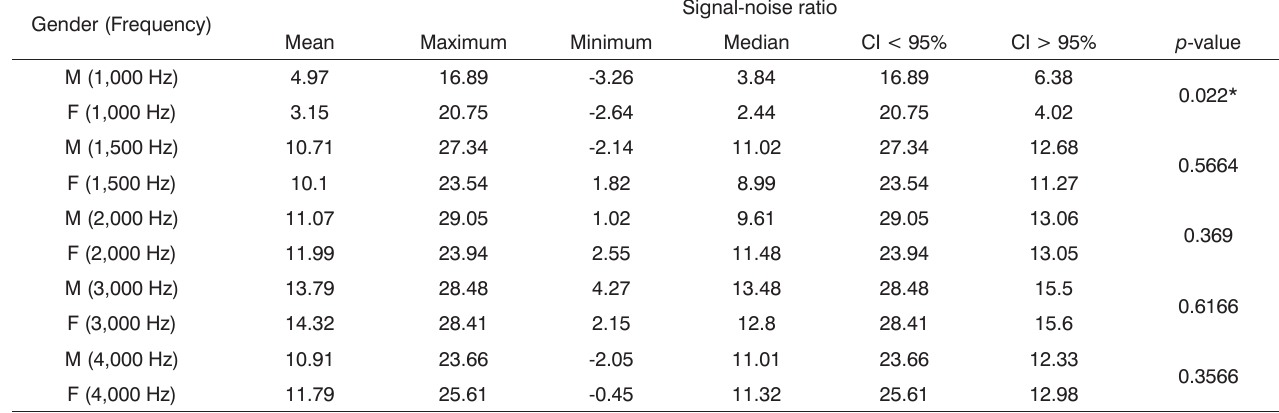
Table 6. Description of the signal-noise ratio variable of TEOAEs (in dB SPL), for full term and preterm newborns according to gender in the 1,000 to 4,000Hz frequency